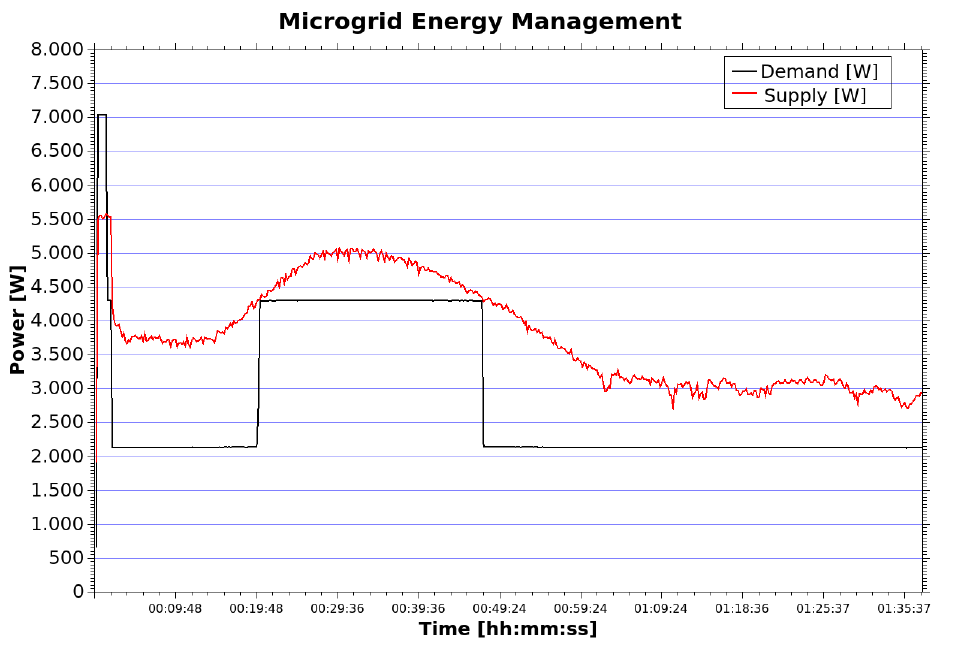
Figure 9. Energy Management for Power